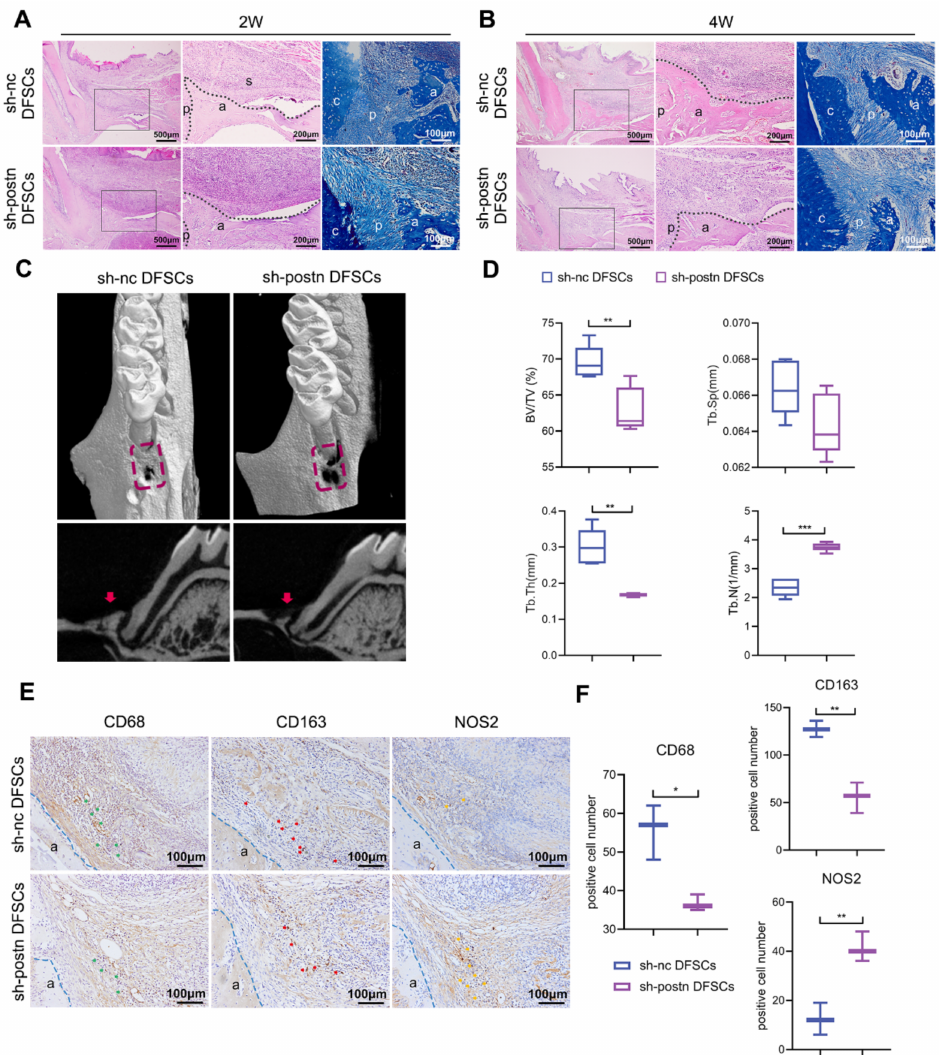
Figure 5. Silencing periostin affected the ability of DFSCs to promote periodontal regeneration. HE and MT staining of periodontal regeneration at 2 weeks ( A ) and 4 weeks ( B ). Middle panel represents a magnified view indicated by the black box in the left panel. The black dotted line shows the edge of the newly formed alveolar bone. a: alveolar bone; c: cementum; p: periodontal ligament; s: DFSCs sheet. Micro-CT images ( C ) and quantitative assessment ( D ) of the defect area at 4 weeks (n = 5). The red dotted box indicates the defect area and the red arrow indicates regenerated alveolar bone. The data of BV/TV, Tb.Sp, and Tb.N were analyzed by unpaired two-tailed Student’s t test. Unpaired two-tailed t tests with Welch correction were used for Tb.Th. The immunochemistry images ( E ) and quantification analysis ( F ) of the CD68+, CD163+, and NOS2+ cells on day 14 after surgery. green arrows: CD68+ cells; red arrows: CD163+ cells; yellow arrows: NOS2+ cells. The data were analyzed by unpaired two-tailed Student’s t test (n = 3). The blue dotted line indicates the outline of the alveolar bone. a: alveolar bone; p: periodontal ligament. * p < 0.05; ** p < 0.01; *** p < 0.001. Error bars represent means ±